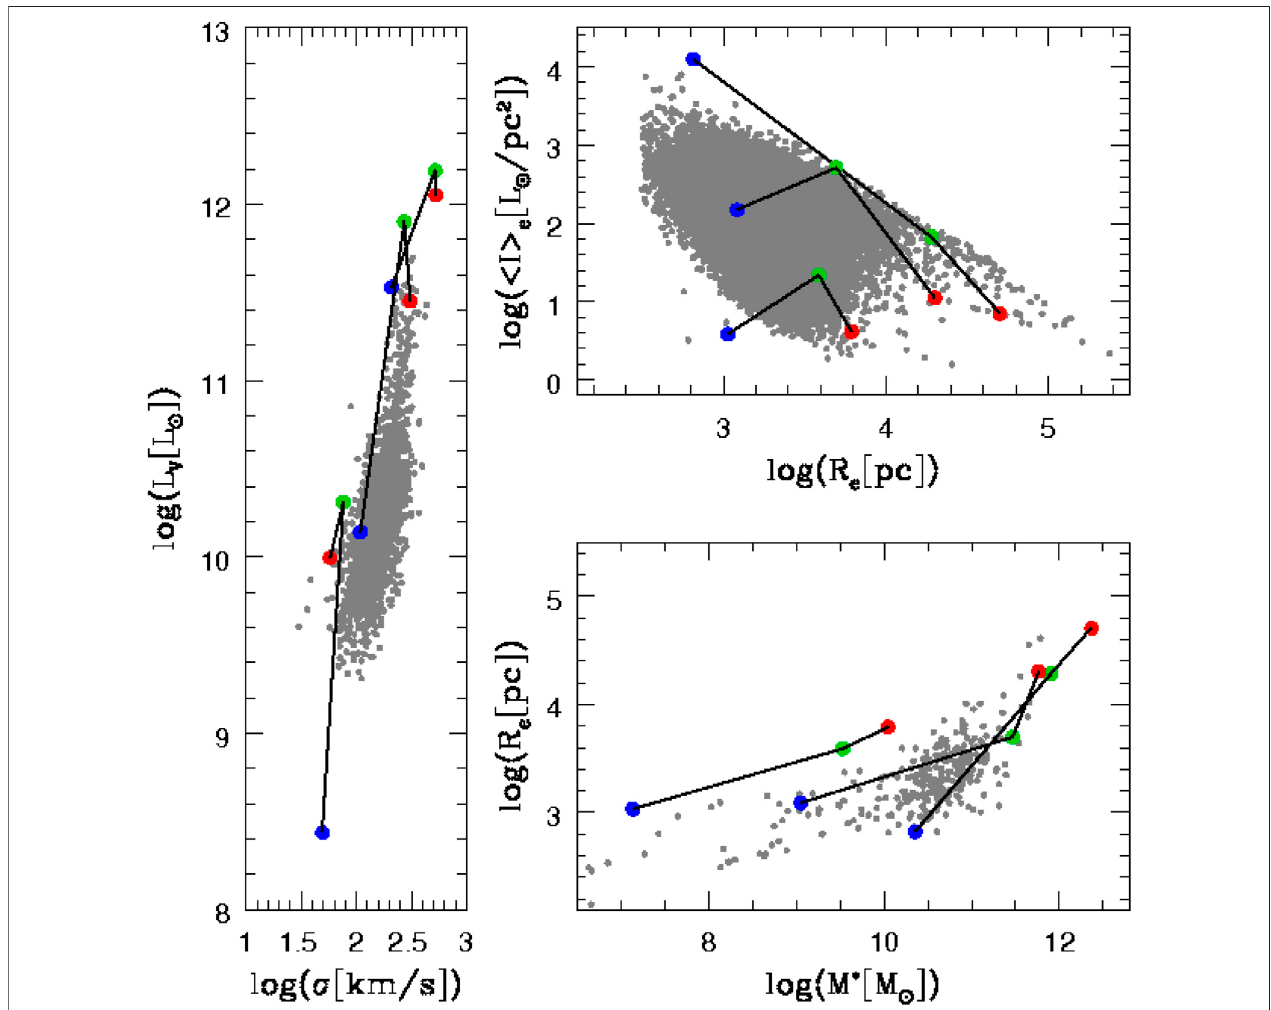
FIGURE 1 | Left panel: the log( σ ) − log( L ) FJ plane. The gray dots mark the observational data extracted from the WINGS database. The colored bigger points connected by lines are three objects extracted from the Illustris simulation respectively at redshift z (cid:1) 4 (blue dot), z (cid:1) 1 (green dot) and z (cid:1) 0 (red dot). The lines show the evolutionoftheseobjectsacrossthecosmicepochs.Rightupperpanel:thelog( R e ) − log( I e )KRplane.TheWINGSgalaxiesareingrayandthecoloreddotsarethesame objects of the left panel. Right lower panel: the log( M s ) − log( R e ) MR plane. The symbols used are the same as before. The number of galaxies changes in each panel because masses and velocities are not available for the whole set of ETGs, in particular for the faint objects.